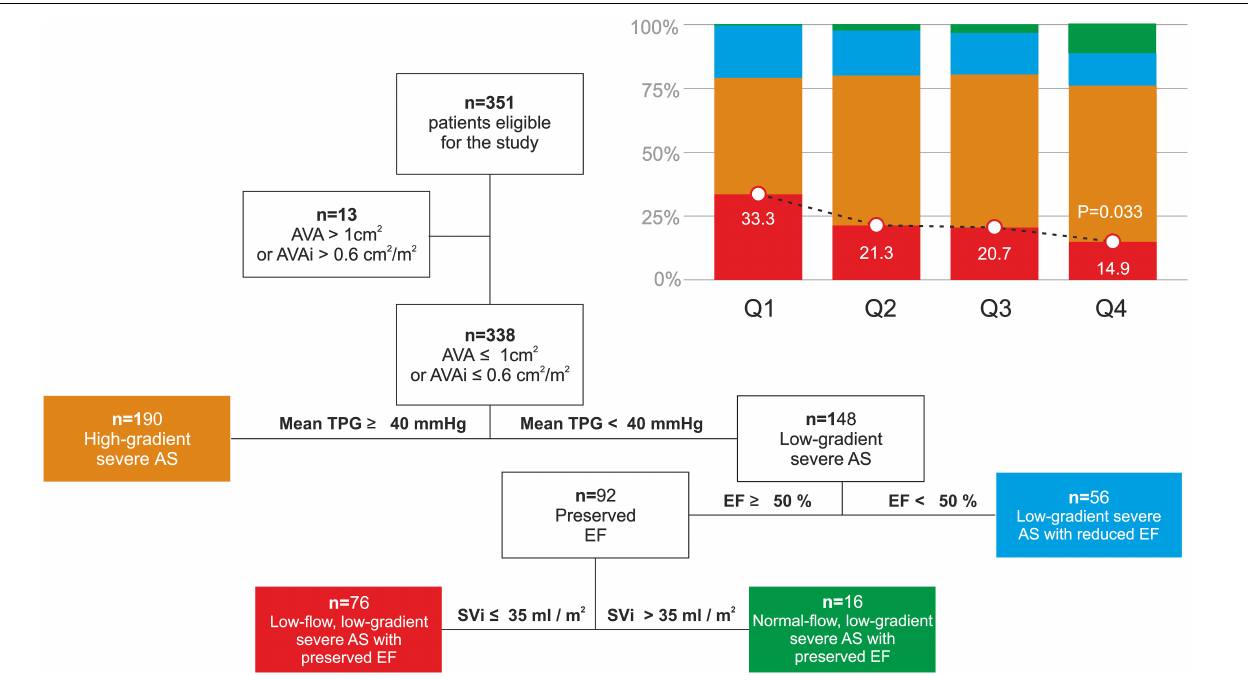
FIGURE 4 | Aortic stenosis classification and incidence of the low-flow, low-gradient severe AS with preserved EF according to the BWTT quartiles. AS, aortic stenosis; AVA, aortic valve area; AVAi, aortic valve area indexed for body surface area; EF, ejection fraction; TPG, transvalvular pressure gradient; SVi, stroke volume indexed for body surface